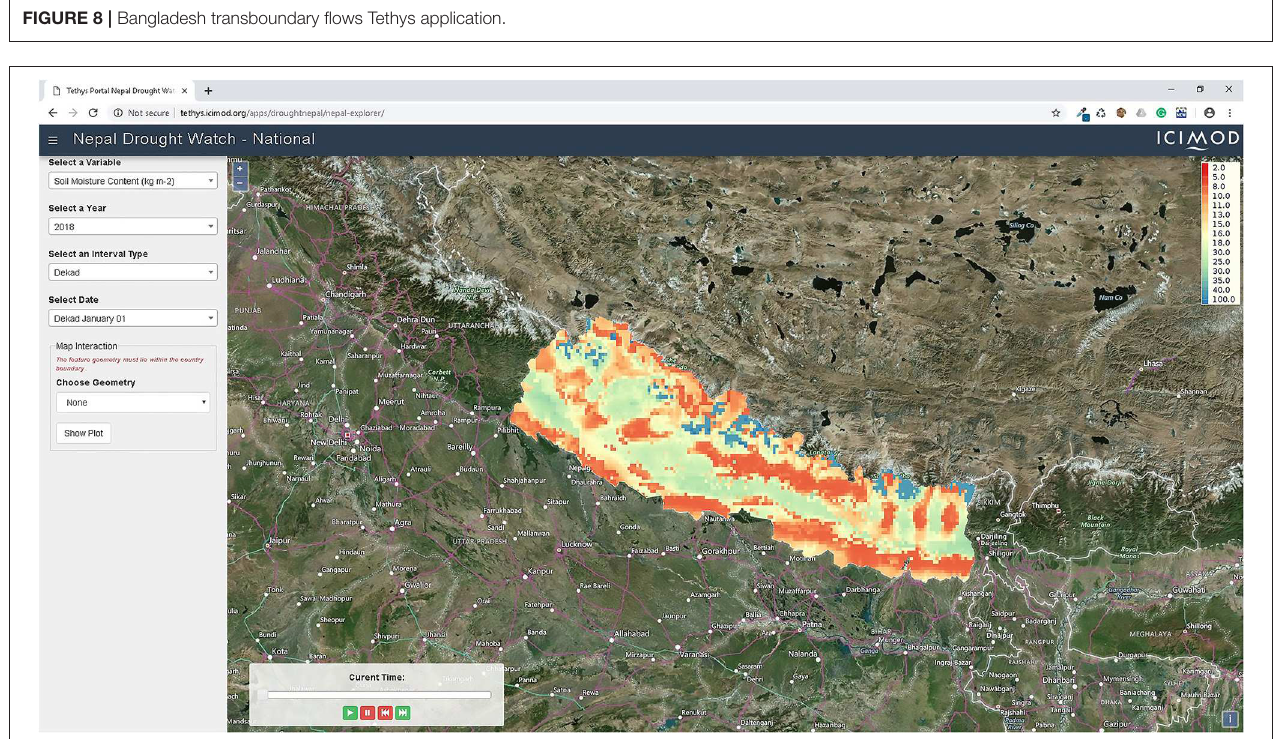
FIGURE 9 | Nepal drought watch—national Tethys application.